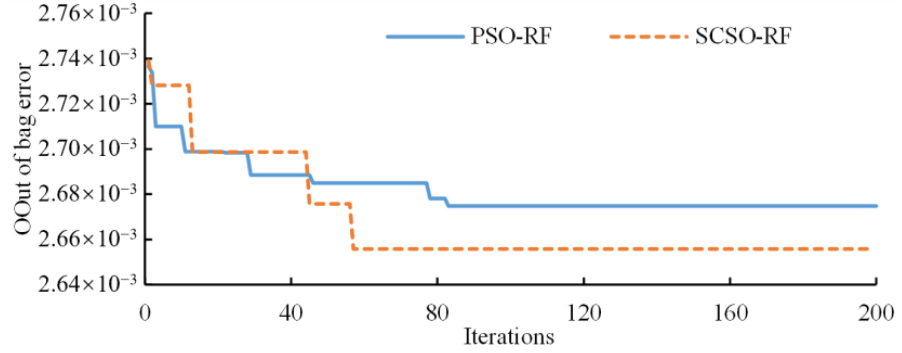
Figure 12. Iterative process of PSO-RF and SCSO-RF.